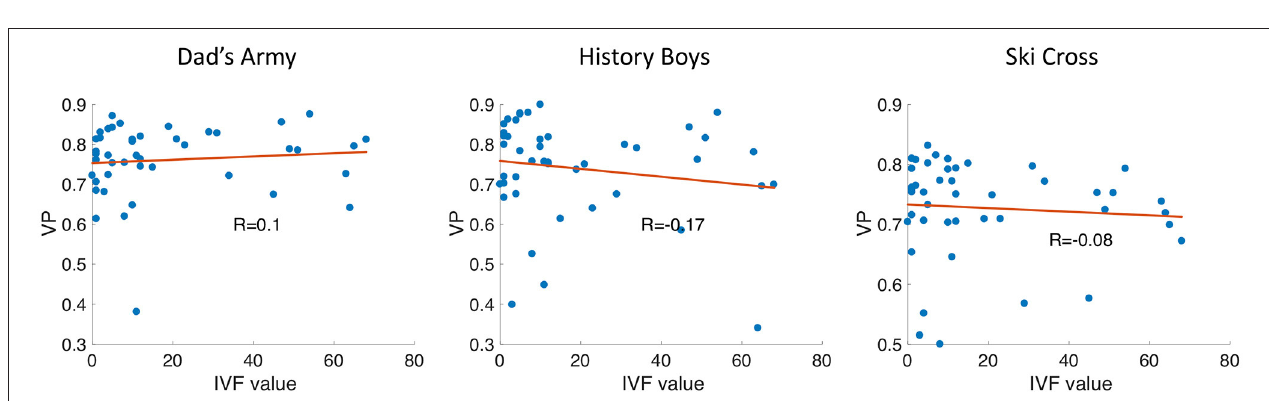
FIGURE 11 | Box and whisker plots showing the group means of VP per movie clip. The circles represent the VP value of each participant.